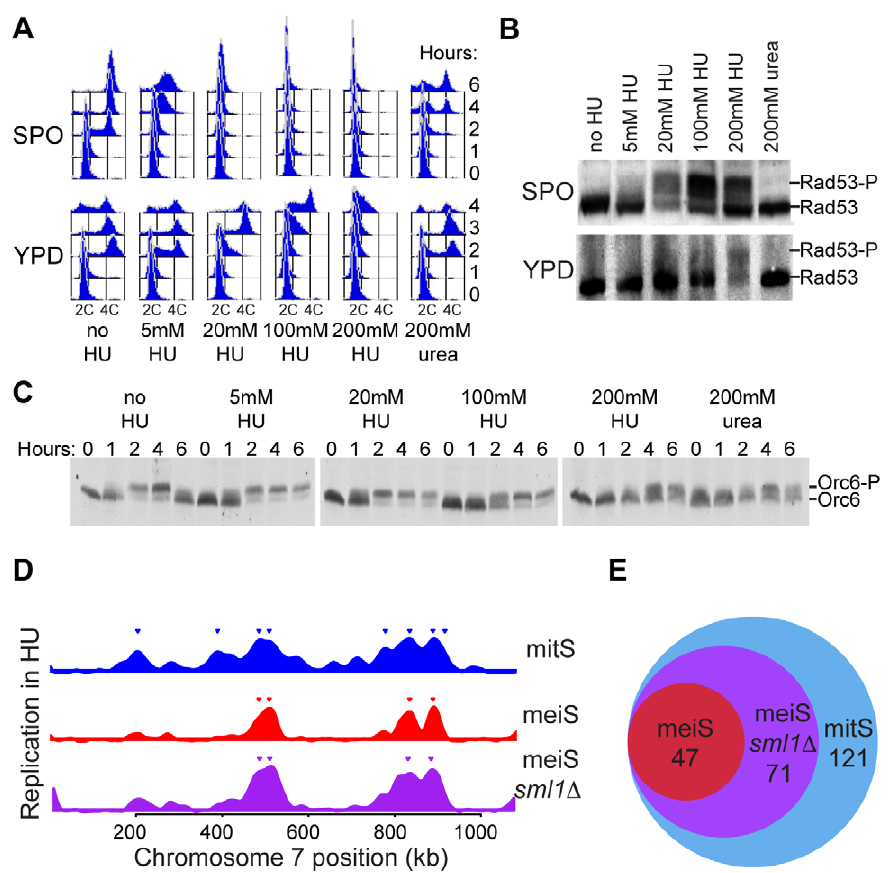
Figure 3. Reduced replication initiation in meiS. Pre-sporulation cultures of wild-type cells (H574) were inoculated into either SPO (top row) or YPD (bottom row) in the absence or presence of the indicated concentrations of HU or urea. (A) Comparison of response to HU in meiS and mitS as measured by FACS analysis. (B) Western blot analysis of Rad53 phosphorylation after 4 hours incubation in SPO (top panel) or YPD (bottom panel). (C) Western blot analysis of Orc6 phosphorylation in cells from the SPO cultures to monitor activation of CDK at the time of S phase entry. (D) The relative copy number enrichment of cells after 4 hours in 200 mM HU (mitS) or 20 mM HU (meiS) is plotted relative to chromosome VII position for wild-type (H574, blue for mitS and red for meiS) and sml1 D cells (H4898, purple). (E) The total number of origins replicated in each of the conditions in (D) is represented as a Venn diagram.